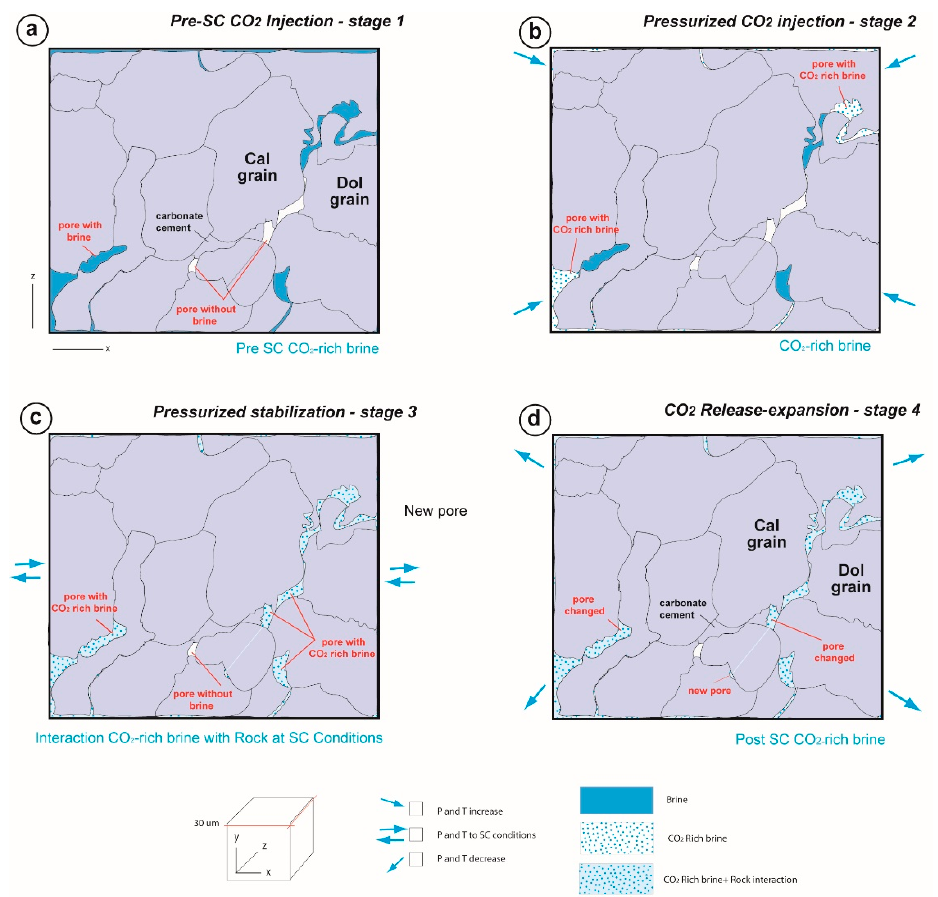
Figure 6. Simplified model developed from the observed mineralogical/textural changes after the SC CO 2 injection in the vuggy carbonates. ( a ) Initial mineralogy and texture of the rock samples: calcite and dolomite composition and brine filling connected pore space; ( b ) Pressurized SC CO 2 injection begins, which dissolves in the brine (CO 2 -rich brine); ( c ) During supercritical experimental stage, the pressurized CO 2 -rich brine reacts with the rock forming minerals producing carbonate dissolution; ( d ) Pressure is released at the end of the experiment and a modified pore network remains.